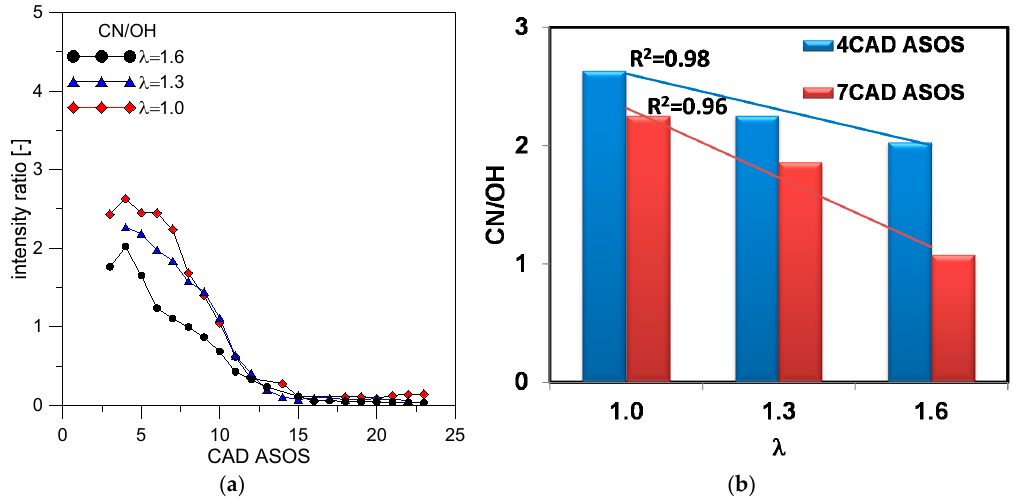
Figure 12. Time evolution of CN (388 nm)/OH (309 nm) emission intensity ratio ( a ) and average value estimated at 4 and 7 CAD ASOS ( b ) at different air–fuel ratios.